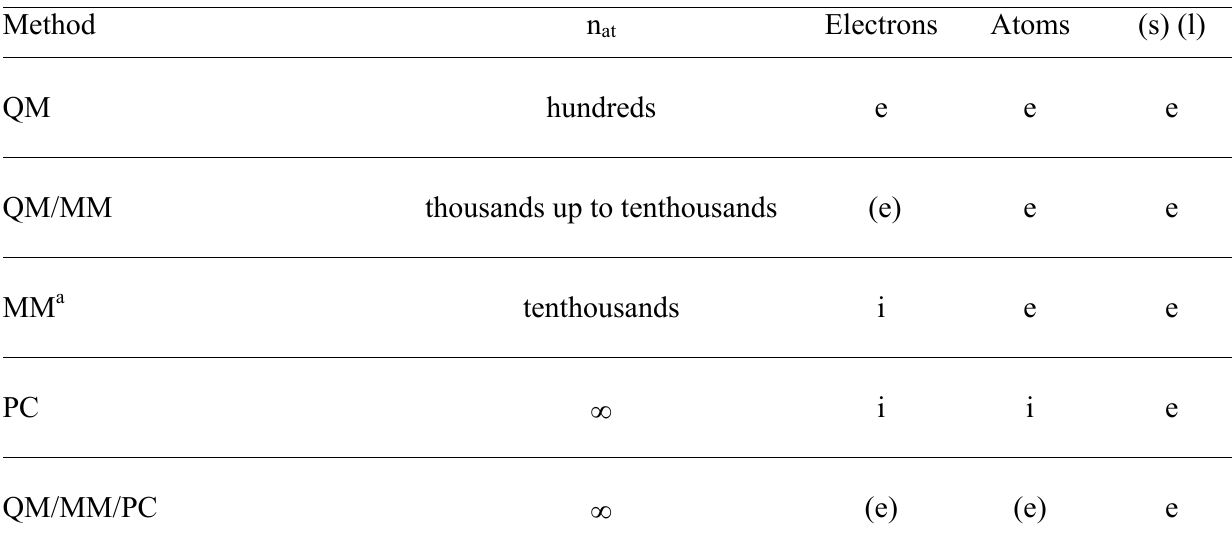
Table 2. How do the individual computational methods consider electrons, atoms, and continuum (liquids or solids): Methods considered: quantum chemistry, QM; molecular mechanics, MM; the physics of a continuum, PC. n stands for attainable number of at